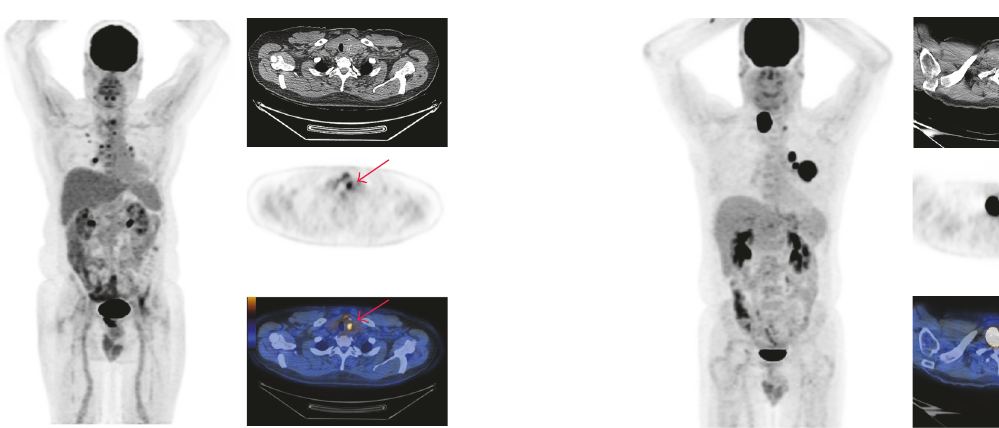
Figure 3: A 56-year-old male with left lung adenocarcinoma demonstrated incidental hypermetabolic thyroid nodule in the right lobe (Case 10). The arrow only refers to the incidental hyperme- tabolic thyroid lesion.